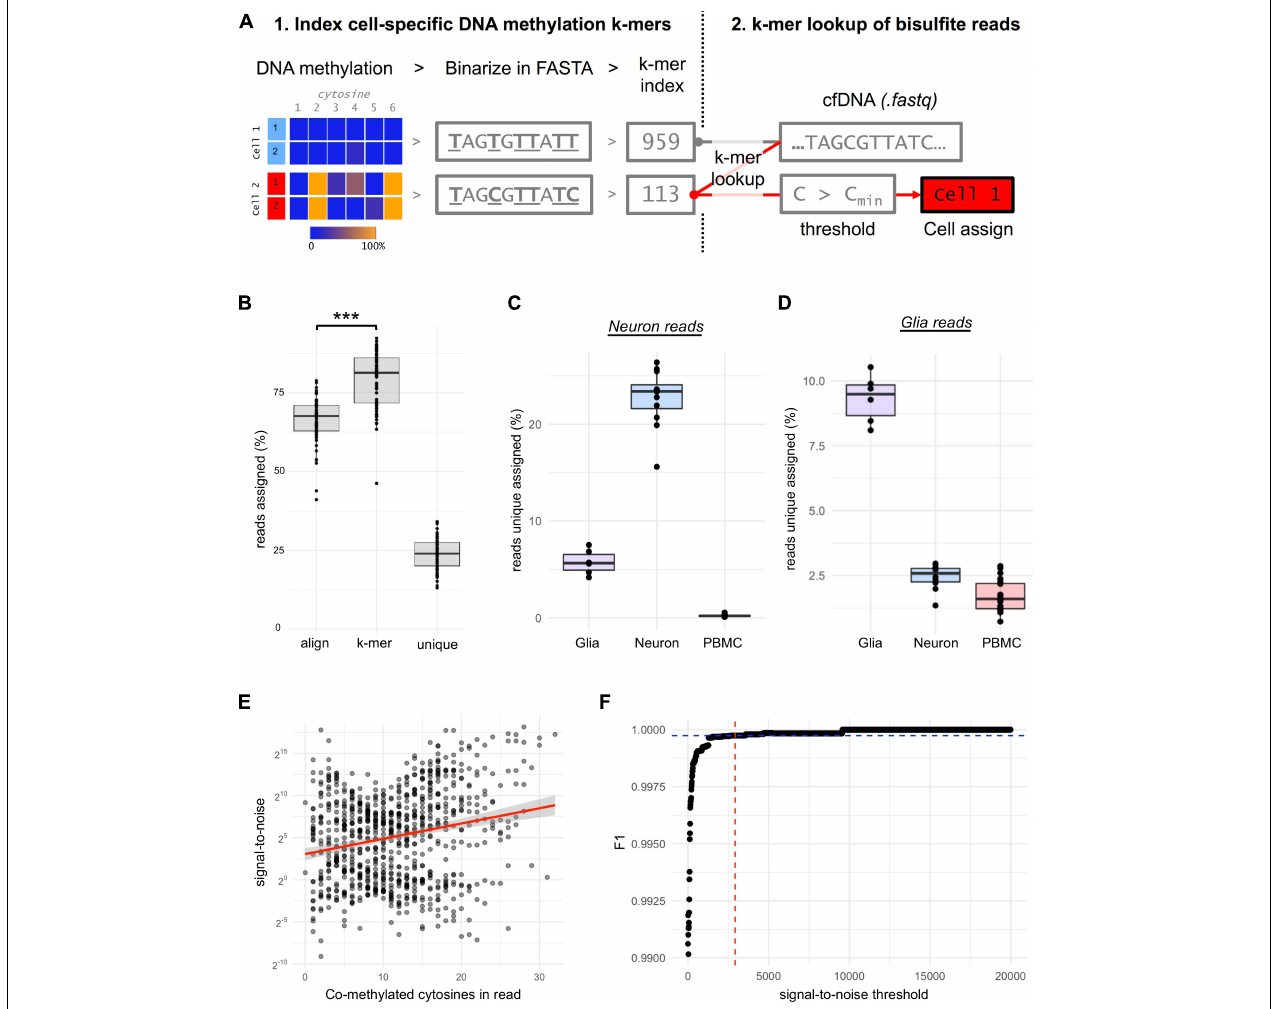
FIGURE 2 | Optimizing the sensitivity and specificity for neuron and glia DNA detection. (A) Procedures for creating cell-specific DNA methylation k-mers. DNA methylation signals (%) of each cytosine are summarized across all samples of a cell-type and binarized ( > / < 50%). The binarized DNA methylation is then inserted into genomic context in FASTA format from which k-mers are indexed. Then raw bisulfite sequencing reads (.fastq eg. from cfDNA) are assigned to cell-types by hash table lookup of indexed k-mers. Co-methylation thresholds, based on signal-to-noise ratios, are then applied to each uniquely assigned read before the read is assigned to its cell-of-origin. (B) Boxplot shows the % of reads from glia (n = 7), neuron (n = 13) and PBMC’s (n = 11) assigned by alignment (bismark) and k-mer assignment to any cell-type (Kallisto) or uniquely assigned to a cell-type. *** p -value = 1.2 x 10–14 (C) Boxplot shows the % of uniquely assigned reads from neuron cells to glia, neuron or PBMC’s. (D) Boxplot shows the % of uniquely assigned reads from glia cells to glia, neuron or PBMC’s. (E) Correlation plot between the signal-to-noise ratio and co-methylation events for each assay for the neuron cell-type. (F) Plot showing the selection of optimal signal-to-noise threshold to accurately assign neuron DNA fragments using the point of inflection (red-blue) of the